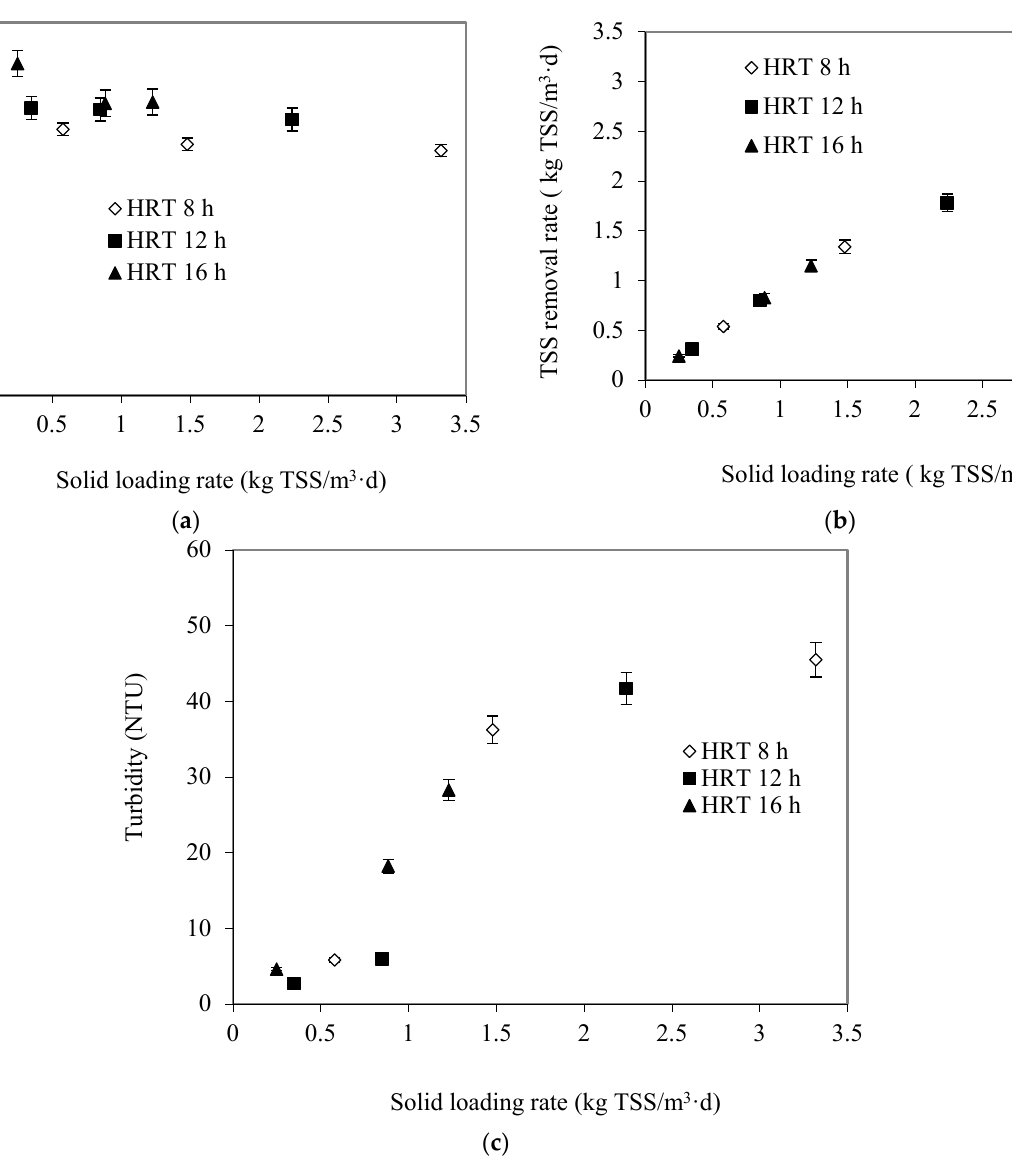
Figure 6. Effect of SLR on ( a ) TSS removal efficiency, ( b ) TSS removal rate, ( c ) effluent turbidity at different HRTs.